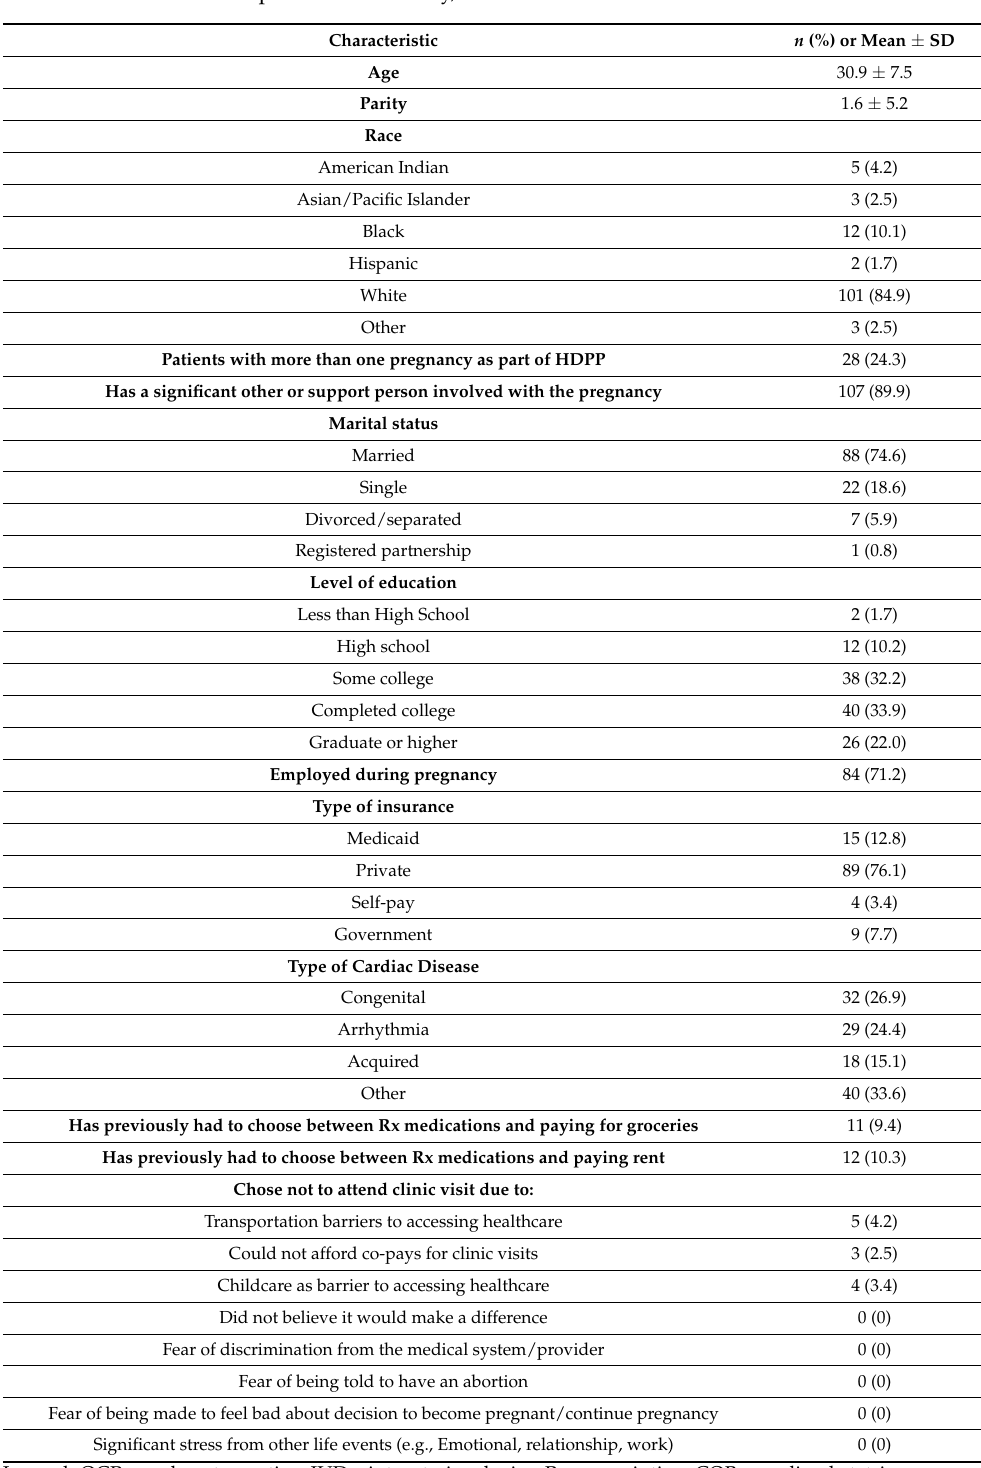
Table 1. Demographic and Sociodemographic Data for 119 Women in the Combined Cardio-Obstetrics Clinic at Saint Luke’s Hospital of Kansas City,